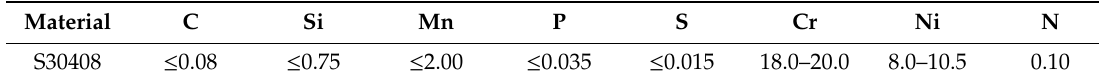
Table 1. Chemical composition of S30408 (wt%) [31].